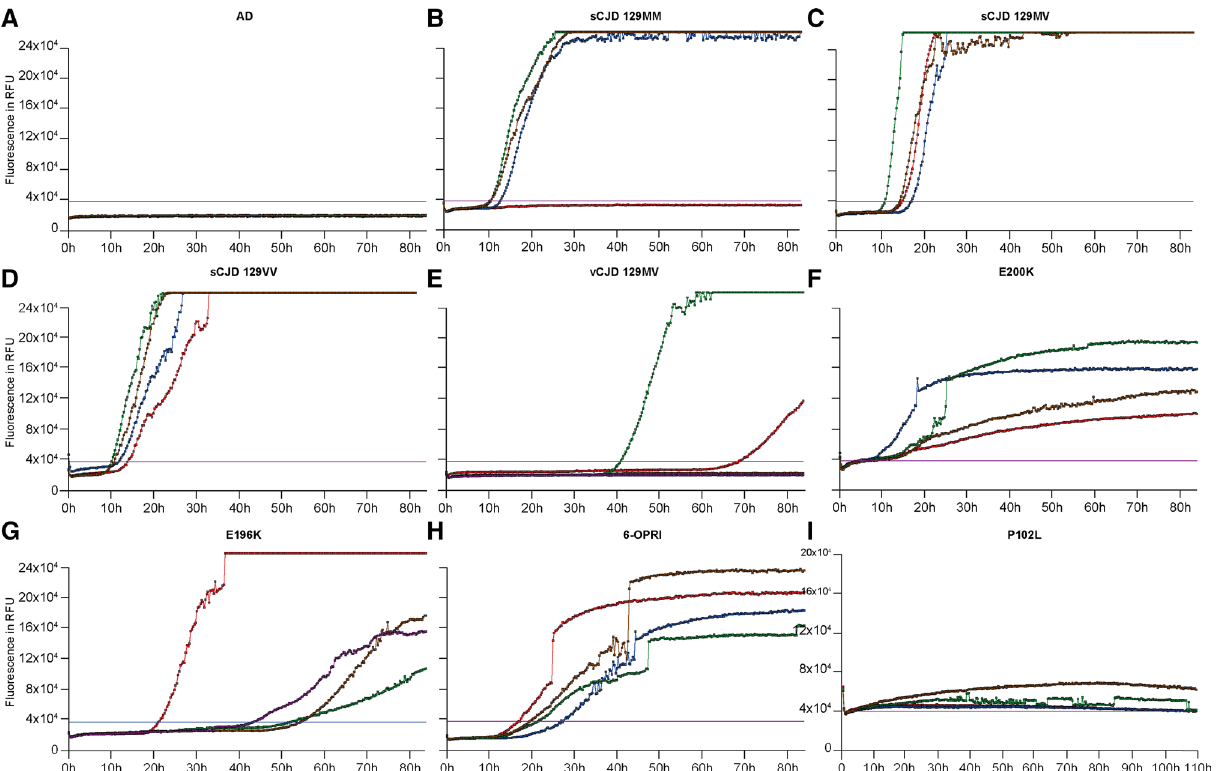
Figure 3. Sample traces of RT-QuIC reactions using BV rPrP in 384-well format. Reaction volumes of 50 μL at 50 °C seeded by CSF from ( A ) Alzheimer’s Disease (AD), ( B ) sCJD 129MM, ( C ) sCJD 129MV, ( D ) sCJD 129VV, ( E ) vCJD 129MV, ( F ) E200K, ( G ) E196K, ( H ) 6-OPRI and ( I ) P102L. Positive results were seen in sCJD with different PRNP codon 129 genotypes, vCJD and a range of IPD mutations, while the reaction seeded by AD CSF remained negative throughout. Individual coloured signal curves in each panel represent the signal curves of each well (of which there are 4) of the corresponding prion species/type indicated.